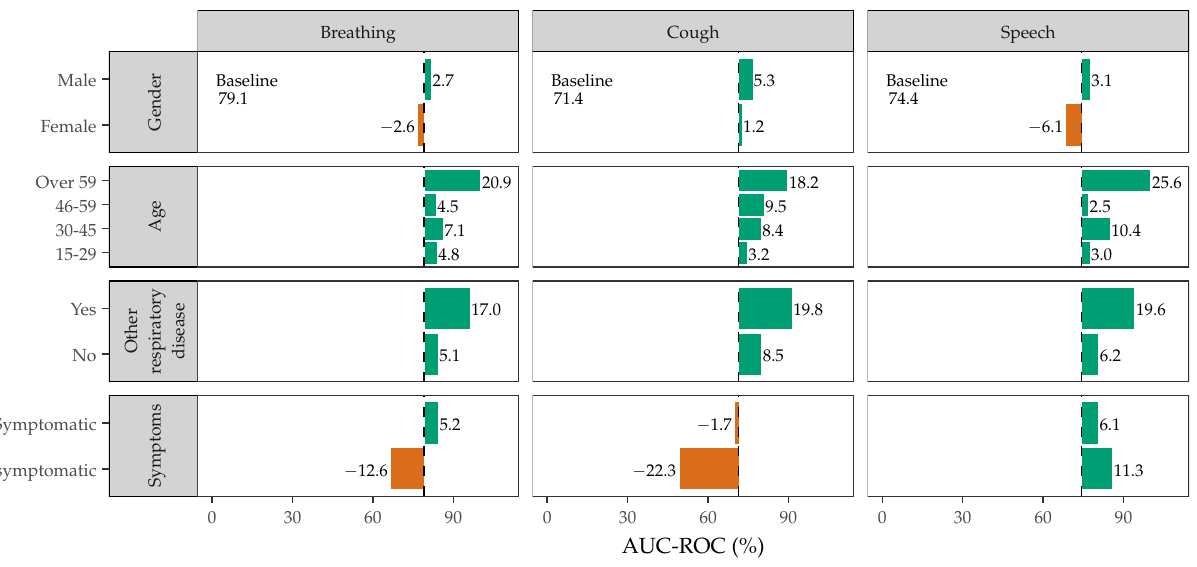
Figure 7. The AUC-ROC of the system when tested on various subsets of data according to gender, age, symptom reporting, or other respiratory disease and compared to the system performance with all datasets of a specific sound type combined (baseline). Green or red bars indicate an increase or decrease above the average performance,